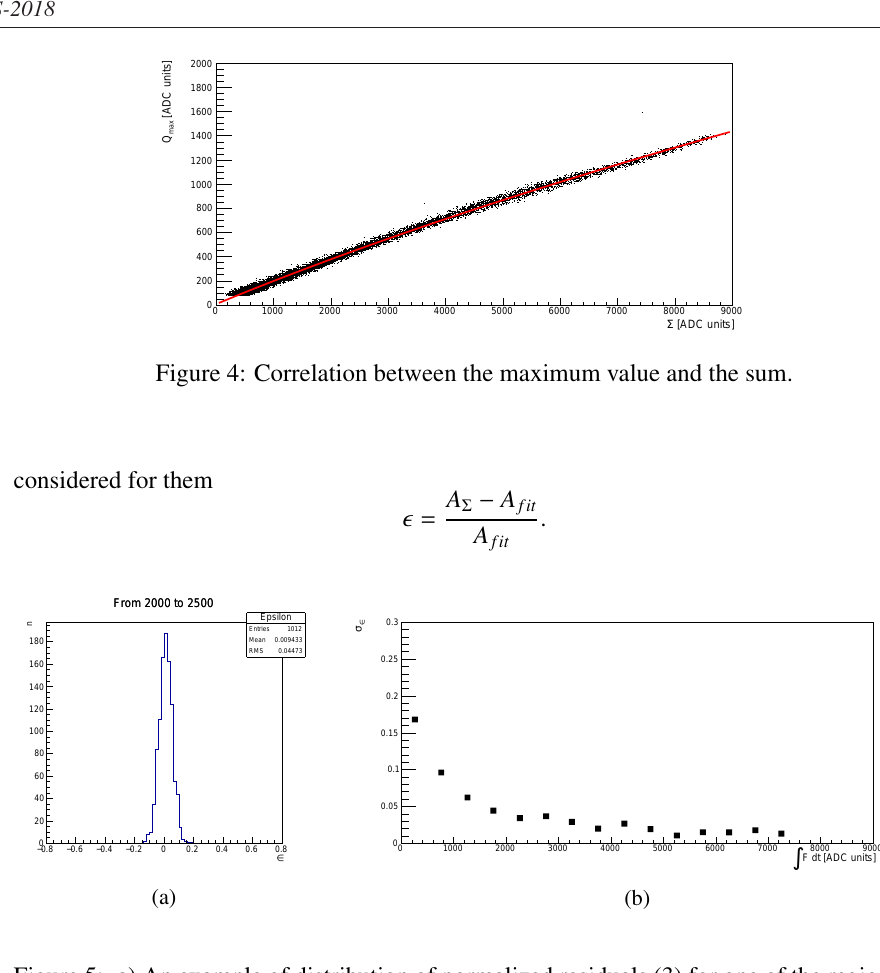
Figure 5: a) An example of distribution of normalized residuals (3) for one of the regions. b) Distribution of RMS for one channel as a function of Σ